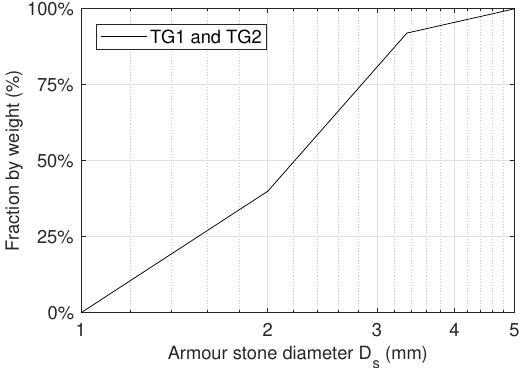
Figure 2. Armour stones applied in the present experiment.